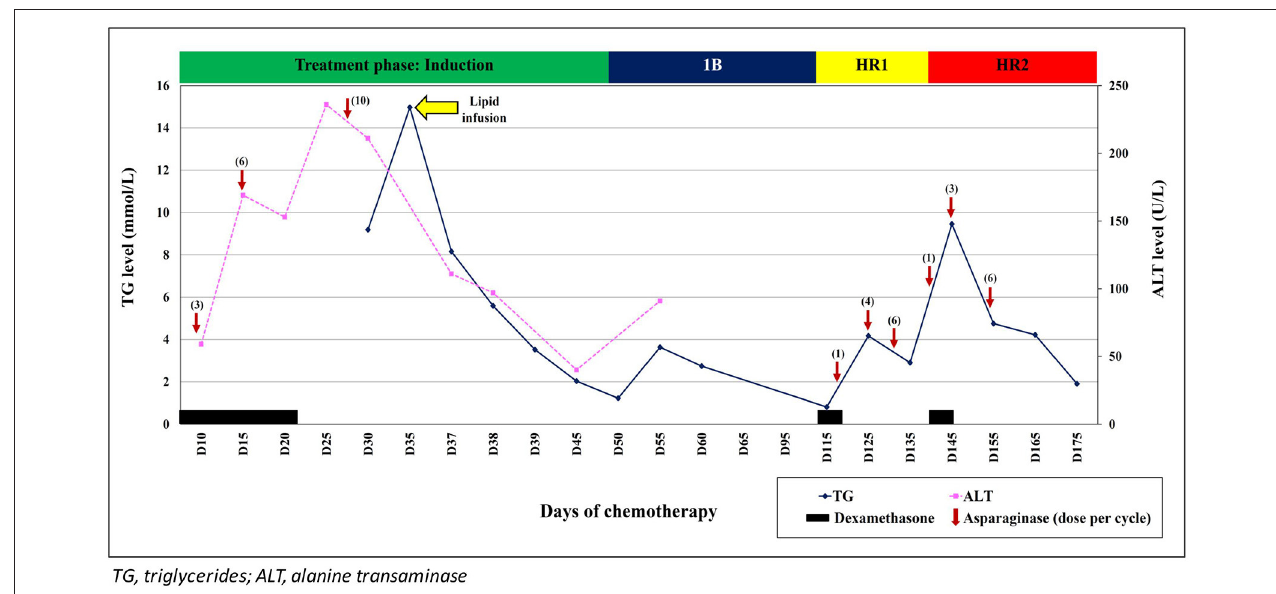
FIGURE 1 | Triglyceride and alanine transaminase (ALT) trends during treatment with L-asparaginase and following infusion of